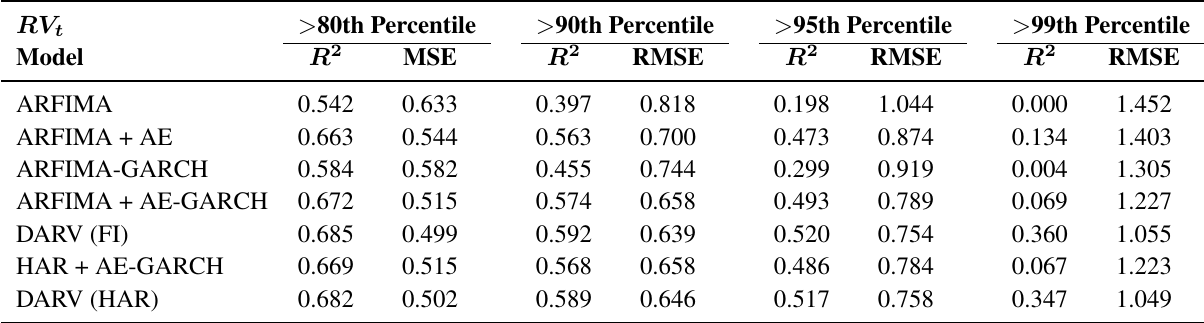
Table 10. Conditional forecasts (S&P 500): high realized volatility.